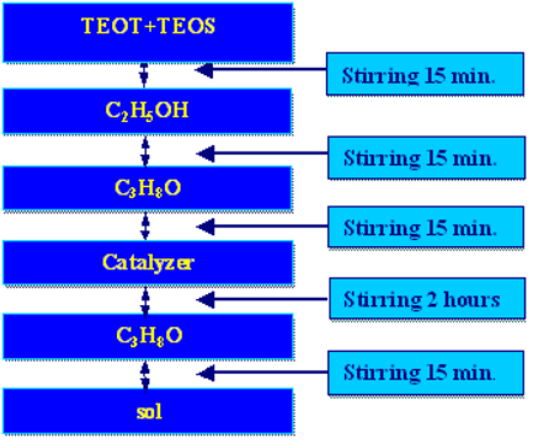
Figure 2. Colour of the sols: A) after preparation, B) two weeks